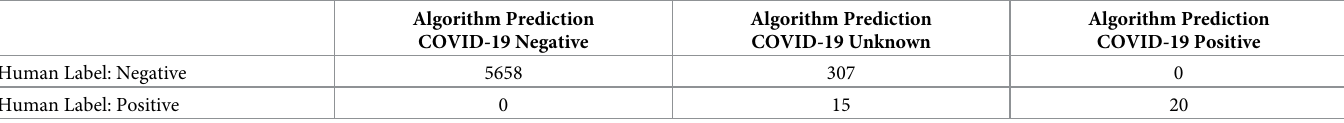
Table 5. Internal validation of the COVID-19 biosurveillance system relative to the aggregated UTOPIAN lab text, health condition diagnosis text and clinical note data sources (N = 6000 independent free text